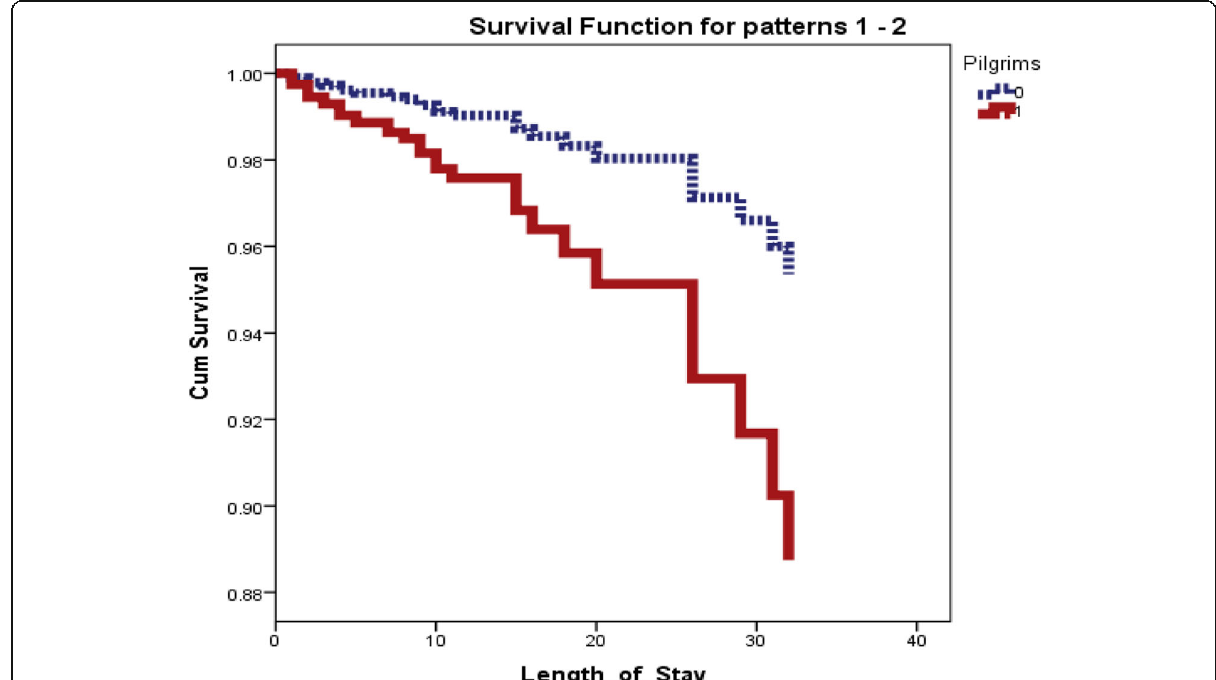
Fig. 2 Regression analysis — pilgrims are independent predictor of the